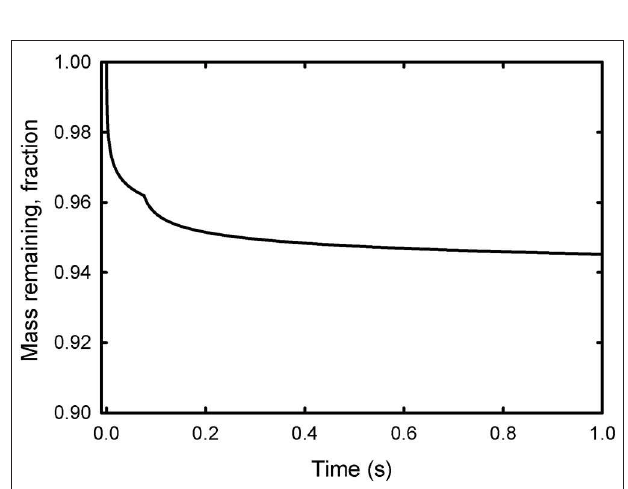
FIGURE 2 | The mass lost as calculated from Equations (v) and (vi) due to sublimation as a function of time for a frozen ice droplet with an initial radius of 10 µ m, relative to its initial mass (set as 1). The change in slope at about 0.1s is due to a change in the coefficient of sublimation from 0.15 to 1.0 at 215K (Kossacki and Leliwa-Kopystynski, 2014). The droplet asymptotically reaches 6–7% mass loss in minutes [as per Equation (iv)].